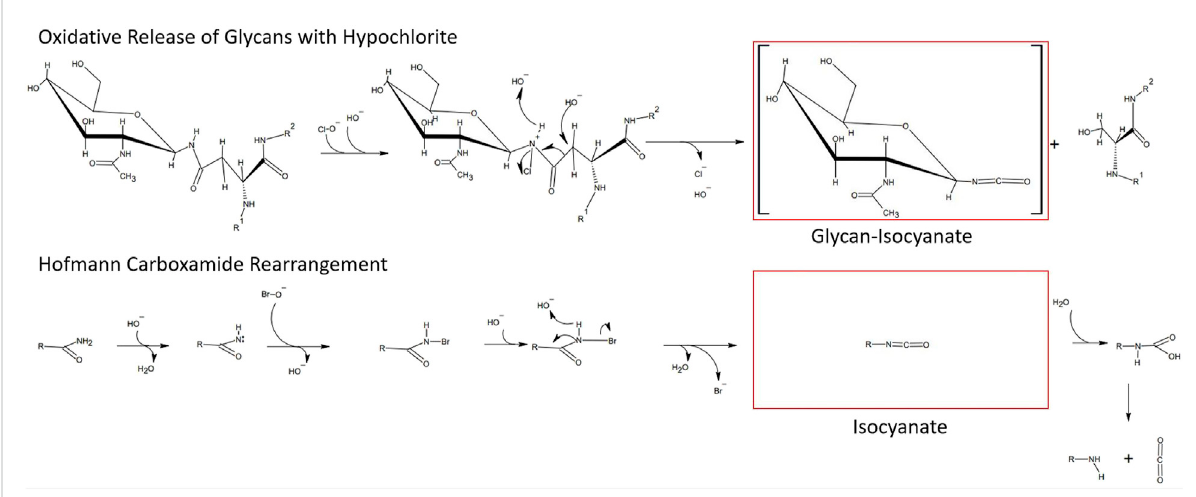
FIGURE 2 Similarities between the hypochlorite method and the Hofmann carboxamide rearrangement. (top) Proposed mechanism for hypochlorite mediated release of glycans. (bottom) Initiating steps in the Hofmann carboxamide rearrangement. Note that both methods proceed under highly alkaline conditions and via an isocyanate